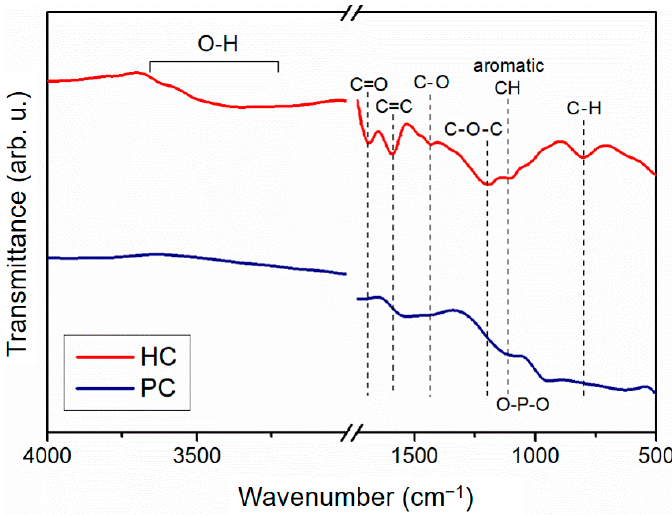
Figure 3. IR spectra of HC and PC.